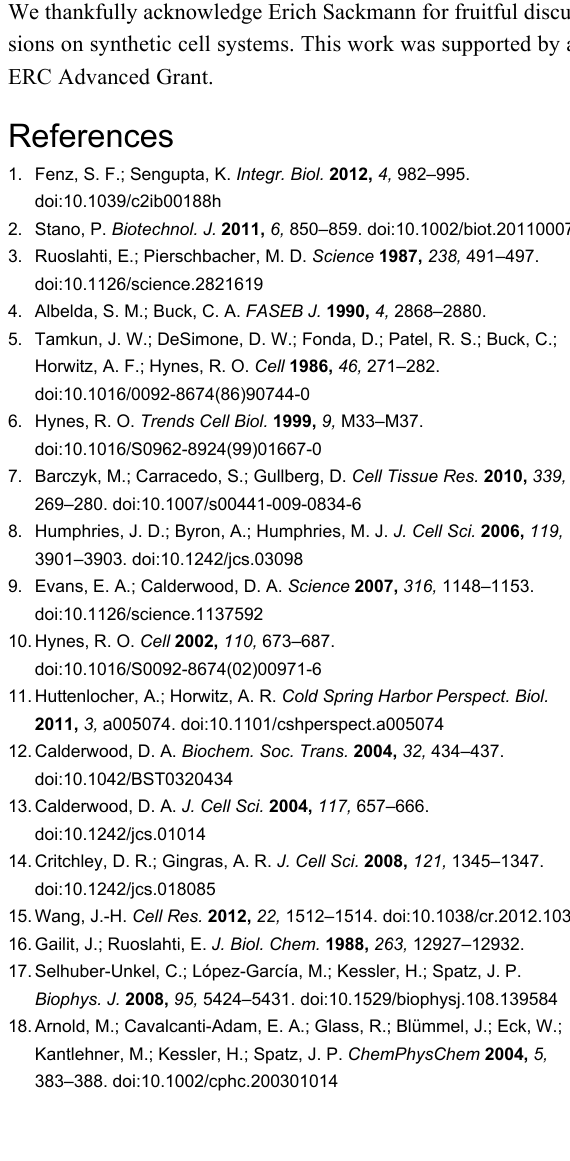
somes, which finally turned into lipid bilayers (Figure 7)